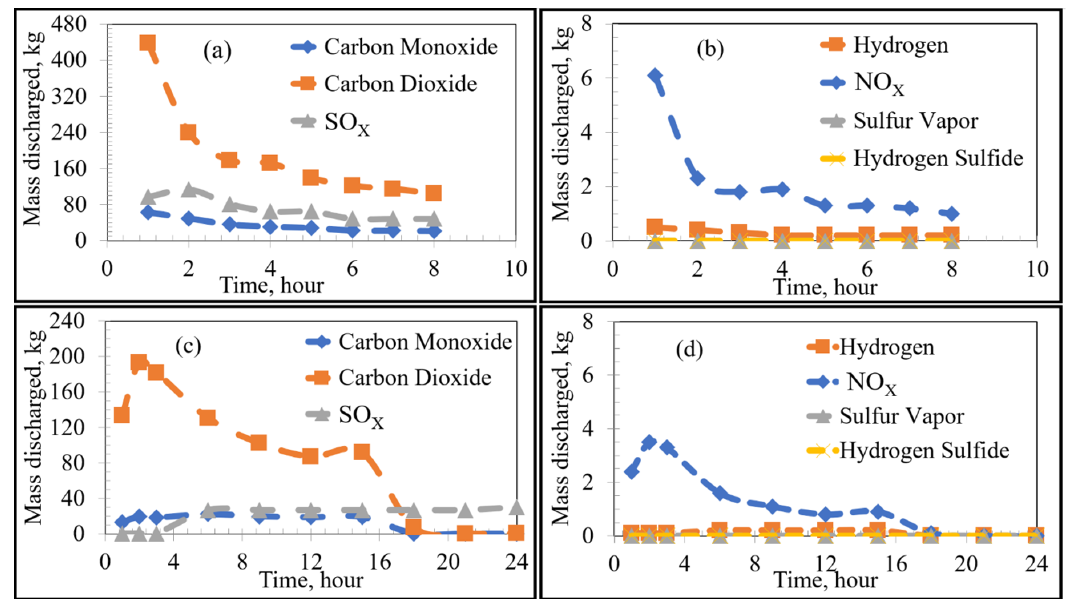
Figure 6 . Emissions under stoichiometric combustion as a function of time: High Sulfur Emission Case; ( a ) and ( b ) show the Current Operation, and ( c ) and ( d ) show the Future Operation.